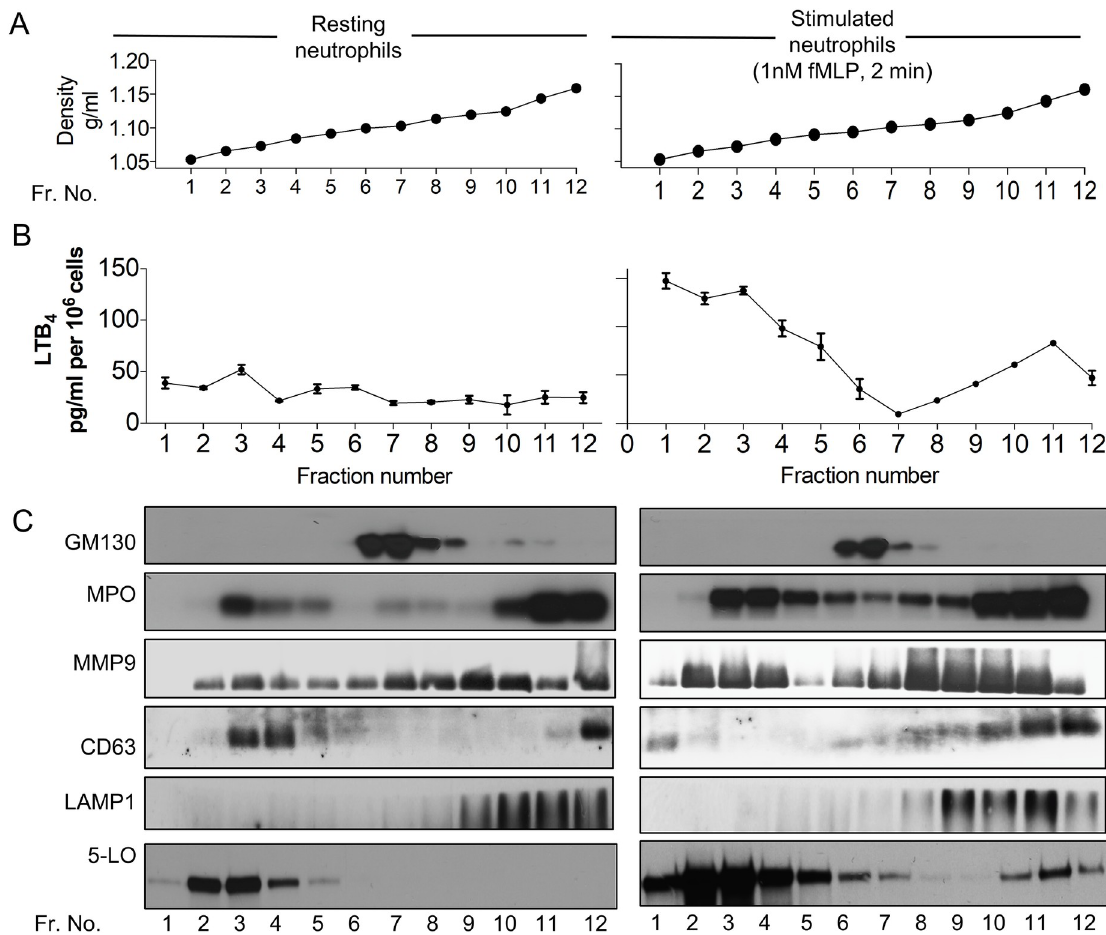
Fig 1. LTB 4 and 5-LO partition with CD63 and LAMP1 positive fractions in continuous iodixanol gradients. ( A) Mock-loaded continuous iodixanol gradients were fractionated and the density of each fraction determined as described. ( B) Nitrogen cavitates of freshly isolated primary human neutrophils were density fractionated on iodixanol gradients, and LTB 4 content from each fraction was extracted and measured by EIA. (C) Total protein from each fraction of iodixanol gradient described in panel B was TCA precipitated, and western analysis was performed using specific antibodies. Data are representative of 2–6 independent experiments. Raw data for panels A and B can be found in the Supporting information section S1 Data file, and uncropped blots for panel C can be found in the S1 Raw images file. fMLP AU : AbbreviationlistshavebeencompiledforthoseusedinFigs 1 (cid:0) 7 : Pleaseverifythatallentriesarecorrect : , N-formylMethionyl-Leucyl-Phenylalanine; LTB 4 , Leukotriene B 4 ; MMP9, matrix metallopeptidase 9; MPO, myleoperoxidase; TCA, trichloroacetic acid; 5-LO, 5-lipoxygenase.